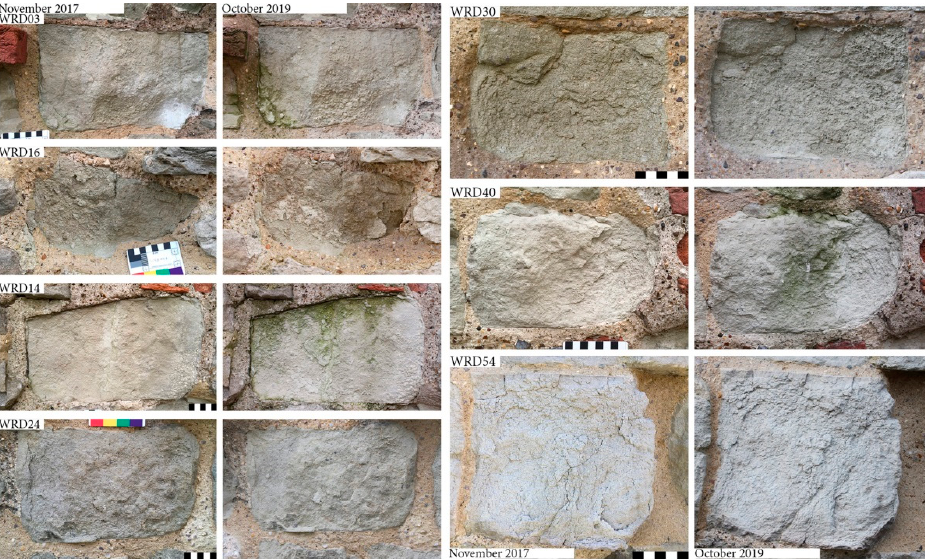
Figure 10. Selection of individual Reigate Stone blocks photographed in November 2017 and October 2019. Some signs of ongoing decay can be associated with inadequate pointing (e.g., WRD16 and WRD14), some can be associated with exposure and macro-context (e.g., WRD03, WRD40, WRD54). There are few examples of ongoing decay which can be more closely associated with type of pointing mortar (WRD24, WRD30).